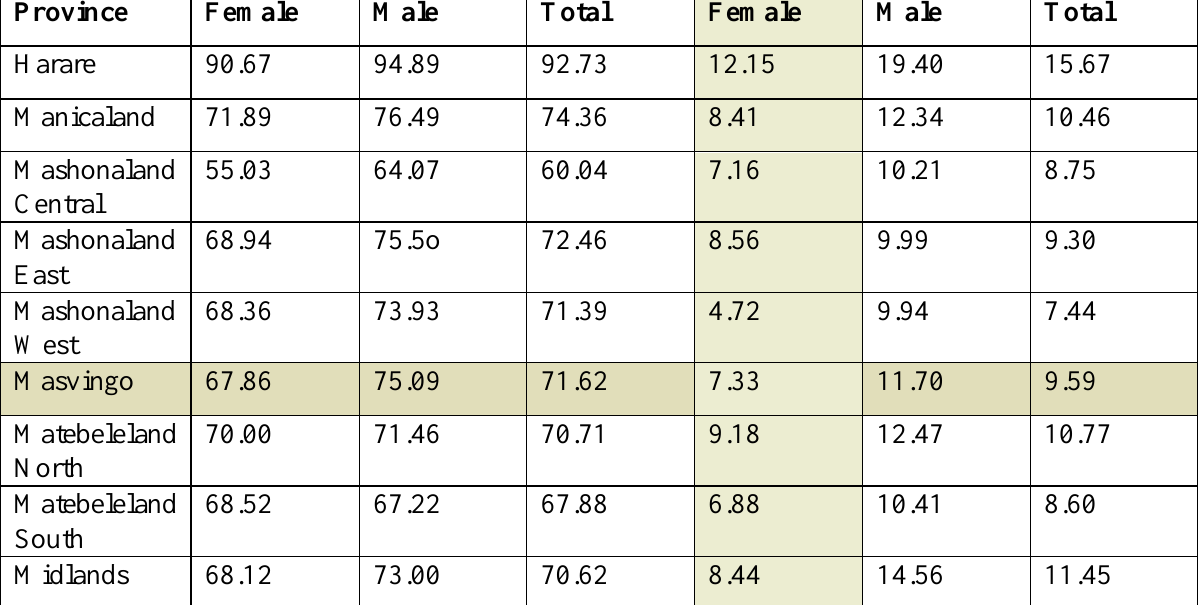
Table 3.3: Secondary School Completion Rates, Form 1 to Form 6, by province, form and sex, Zimbabwe